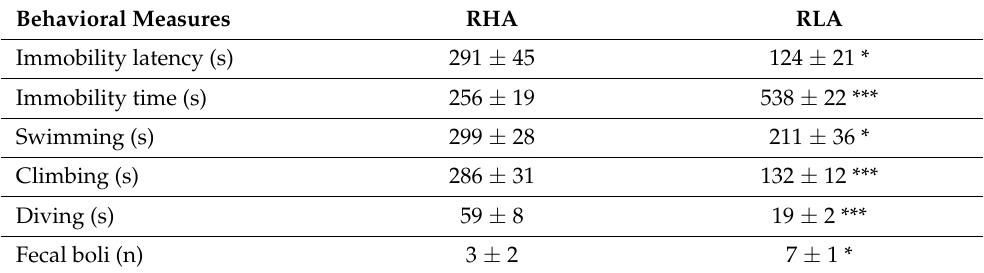
Table 1. Behaviors displayed by RHA and RLA rats during the forced swimming session 1 .